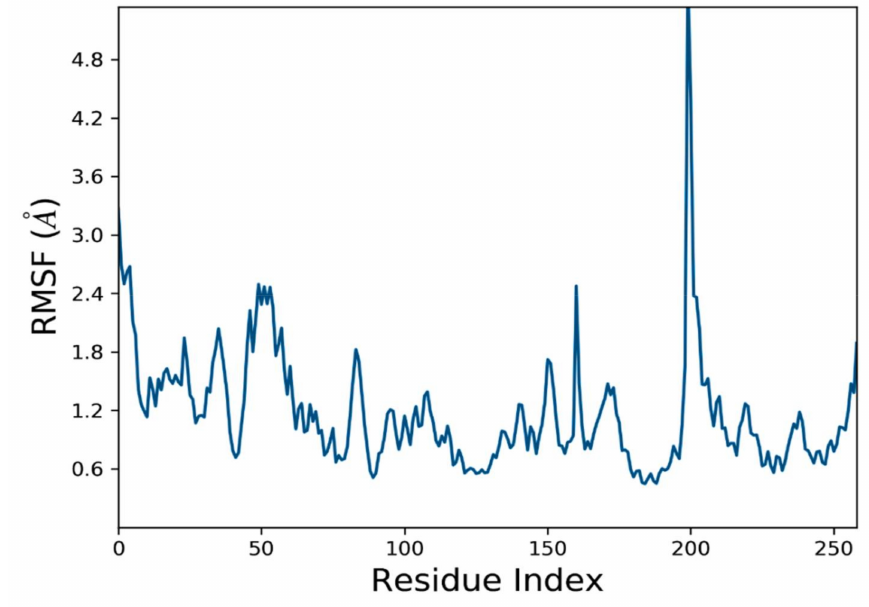
Figure 12. Root-mean-square fluctuations (RMSF) of the C-alpha atoms of NEK7 (2wqn). The contact profiles of NEK7–Dabrafenib were computed from simulated trajectories, as shown in Figure 13. FDA-approved drug Dabrafenib interacted with ILE40, LYS163